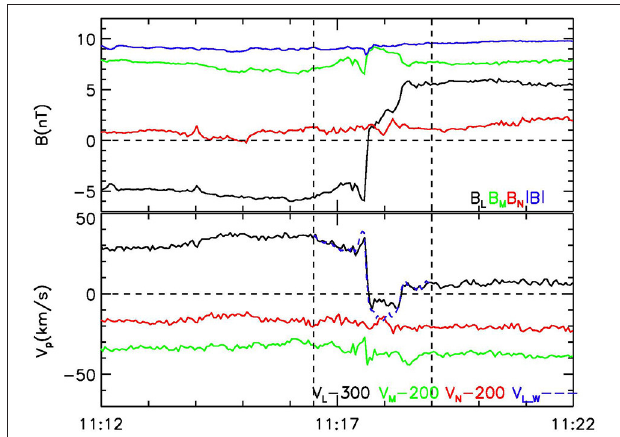
FIGURE 8 | The reconnection exhaust around 11:18 UT November 16th measured by Wind. The format of the figure is same as Figure 3 .